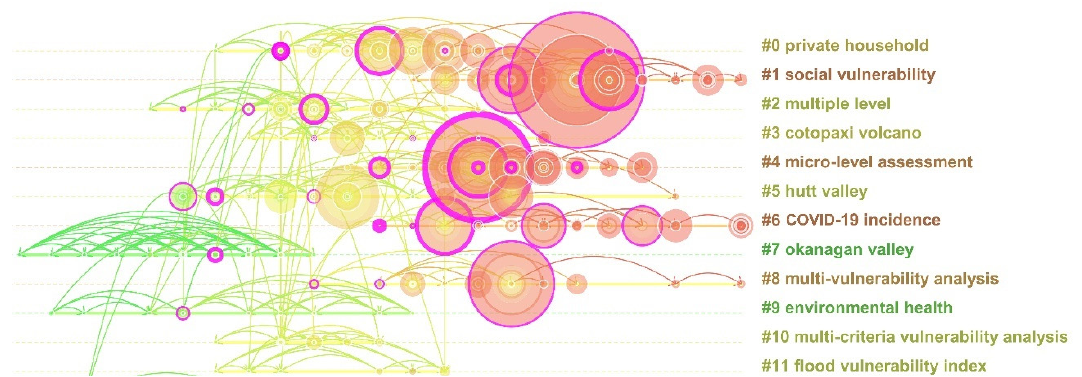
Figure 5. Co-citation timeline visualization of the 11 clusters. Table 1. The five largest clusters sorted by size.